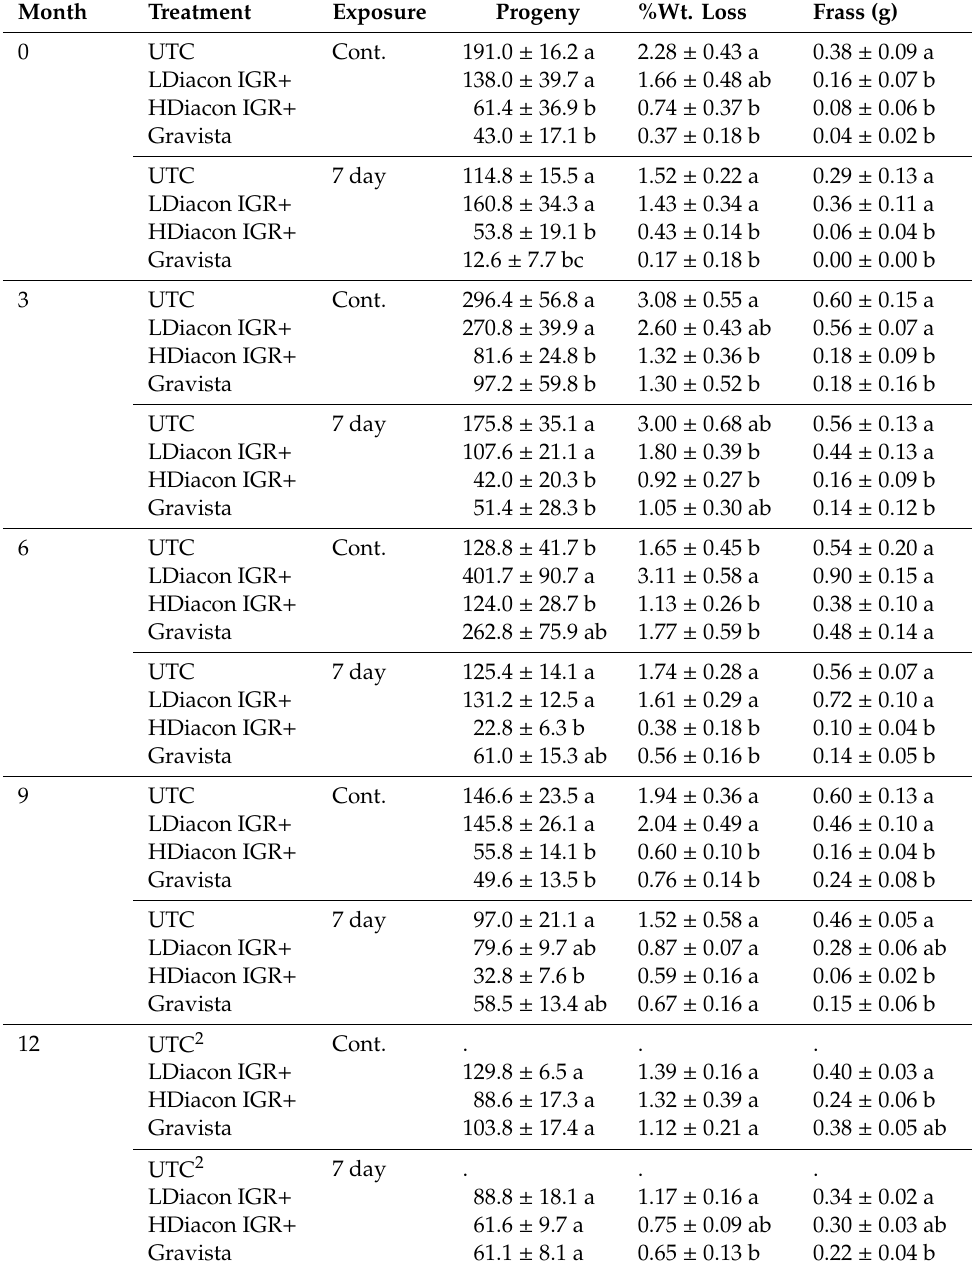
Table 5. Number of F 1 adult progeny, % of sample weight loss due to insect feeding, and feeding damage (frass) (mean ± SE for all) from exposure of ten mixed-sex parental adult S. oryzae exposed on ~80 g of untreated wheat (UTC) wheat or wheat treated with the low rate of Diacon IGR + (LDiacon IGR + , 0.5 ppm deltamethrin + 1.25 ppm methoprene), the high rate of Diacon IGR + (HDiacon IGR + , 1.0 ppm + 2.5 ppm methoprene), or the Gravista. Parental adults were either continuously